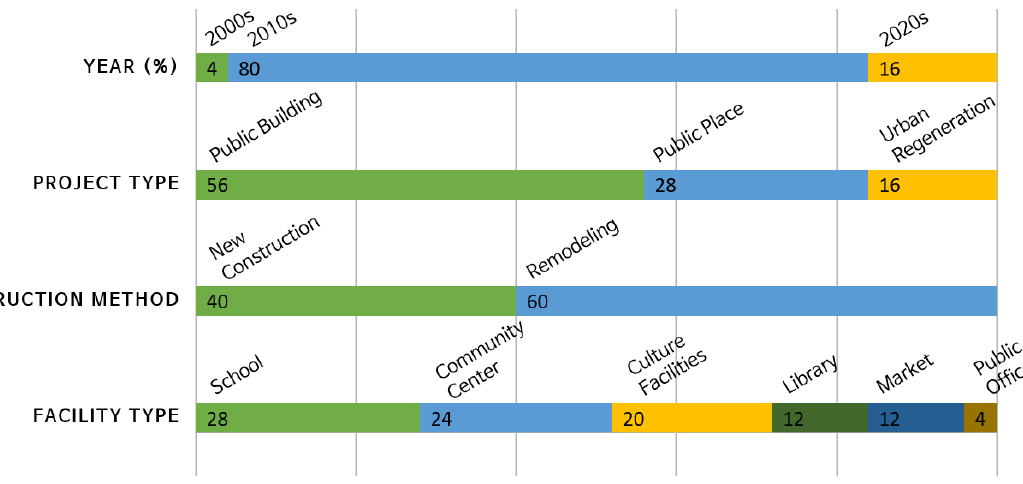
Figure 2. Types of public architecture created through participatory planning in Korea (Source: [33]).